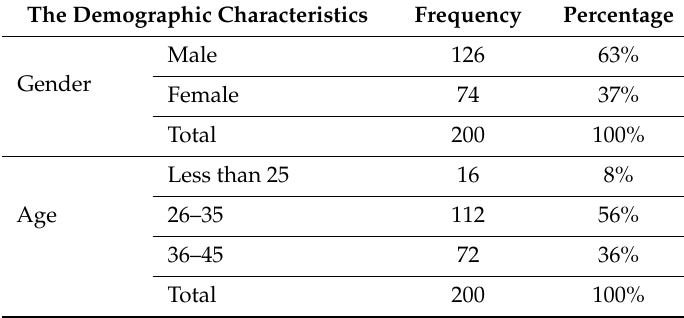
Table 1. Demographic data of the sample.